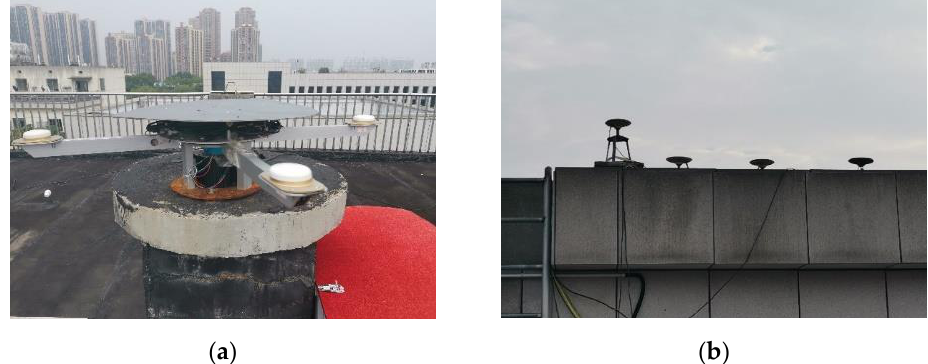
Figure 8. The experimental scene and equipment. ( a ) The rotating platform and four dynamic receiver antennae. ( b ) Static receiver antennae.